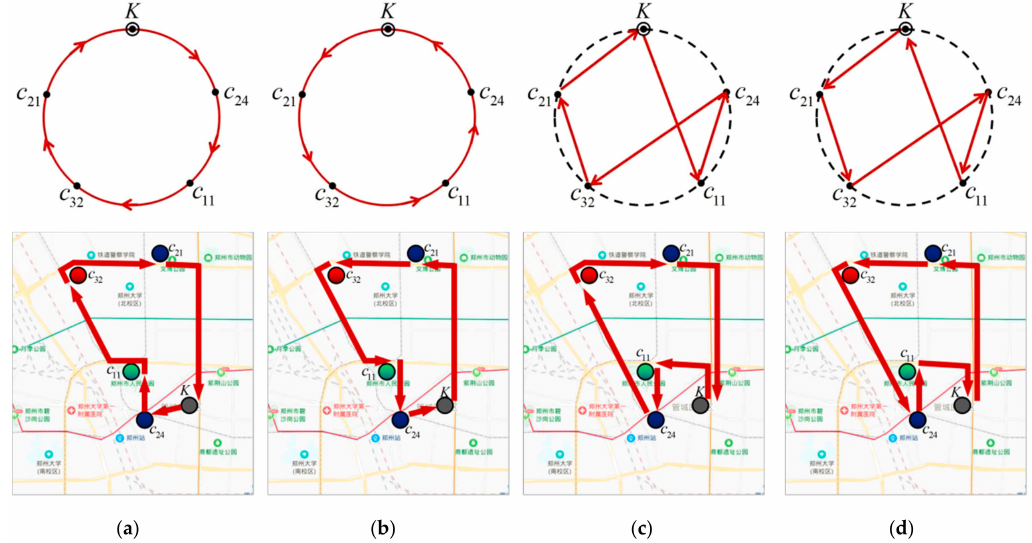
Figure 9. The generation tree closed-loop structures and guide maps output by a smart machine. ( a ) Related to the No.(1) tour route, ( b ) Related to the No.(24) tour route, ( c ) Related to the No.(7) tour route, ( d ) Related to the No.(23) tour